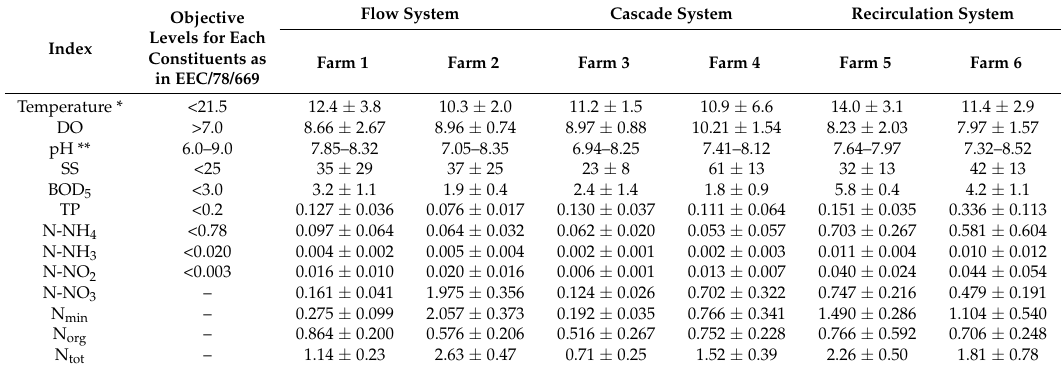
Table 3. pH value and mean concentration of substances in waters outflowing from fish farms (mg·dm − 3 ).